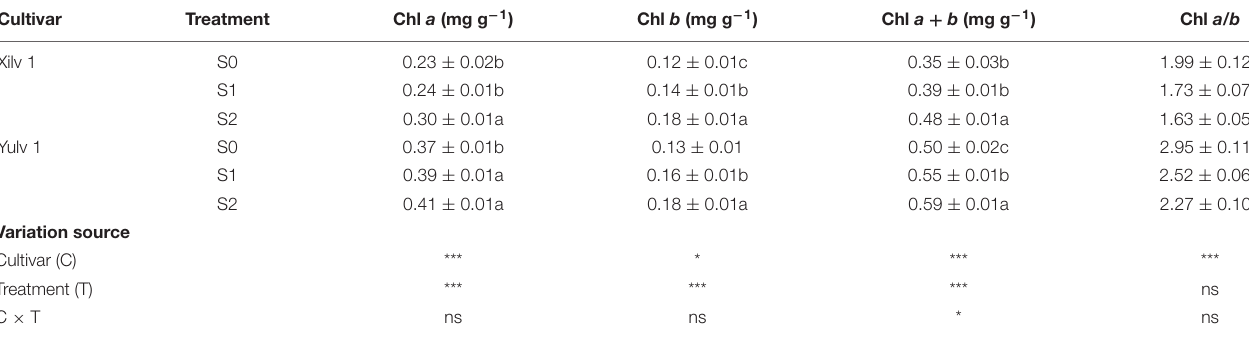
TABLE 1 | Effect of shading stress on the leaf chlorophyll concentration in mung bean. Cultivar